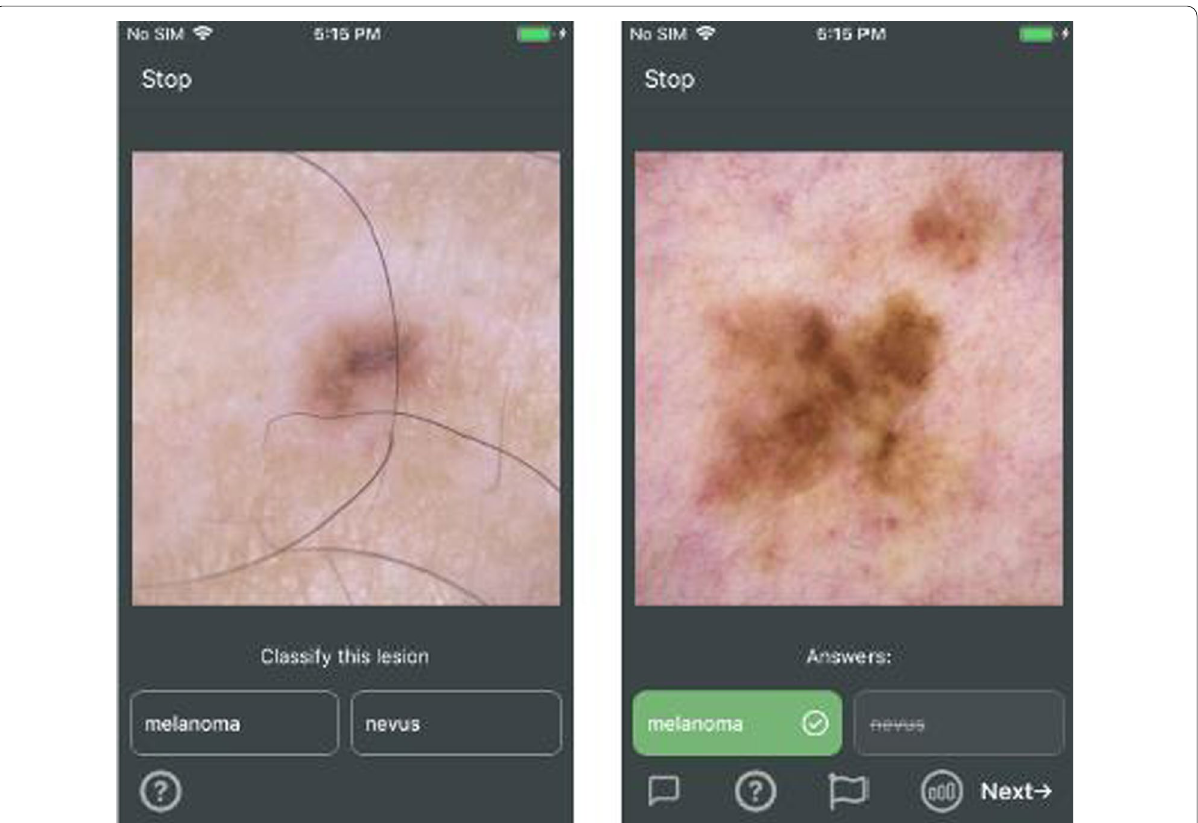
Fig. 1 Sample stimulus displays. Left: participants are asked if a lesion is a melanoma (cancer) or a nevus (benign ‘mole’). Right: after response, if this were a feedback condition, red or green feedback would inform the participant of the correctness of the answer. In no feedback conditions, neutral feedback indicated that the response had been registered